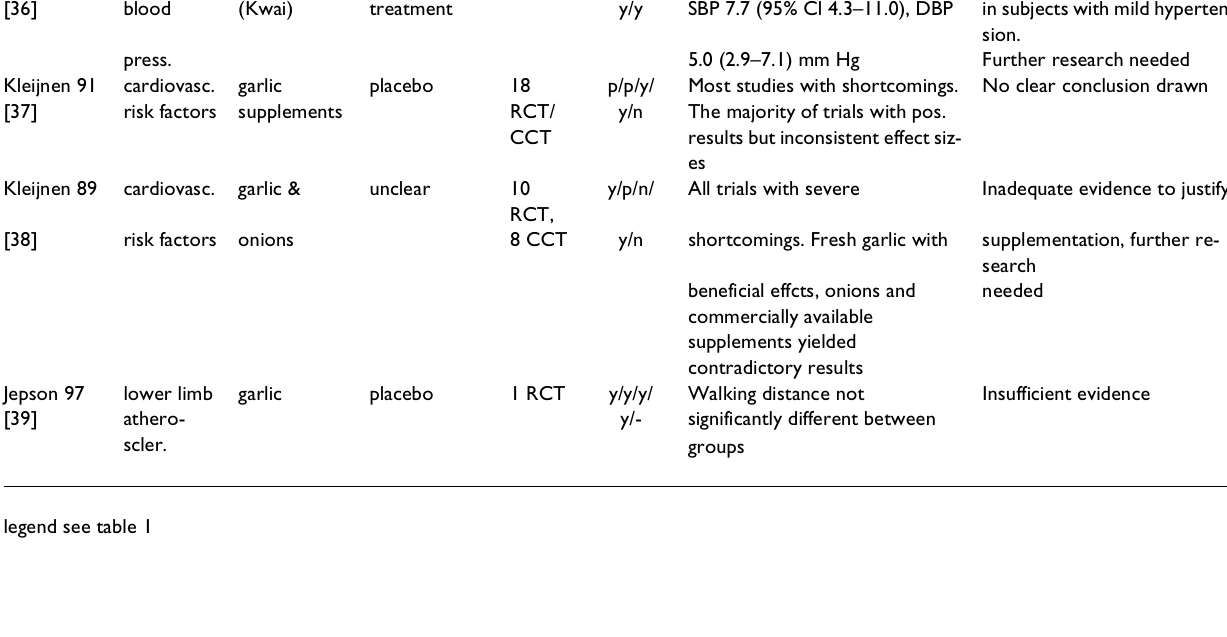
Table 2: Systematic reviews of clinical trials of hypericum and garlic preparations